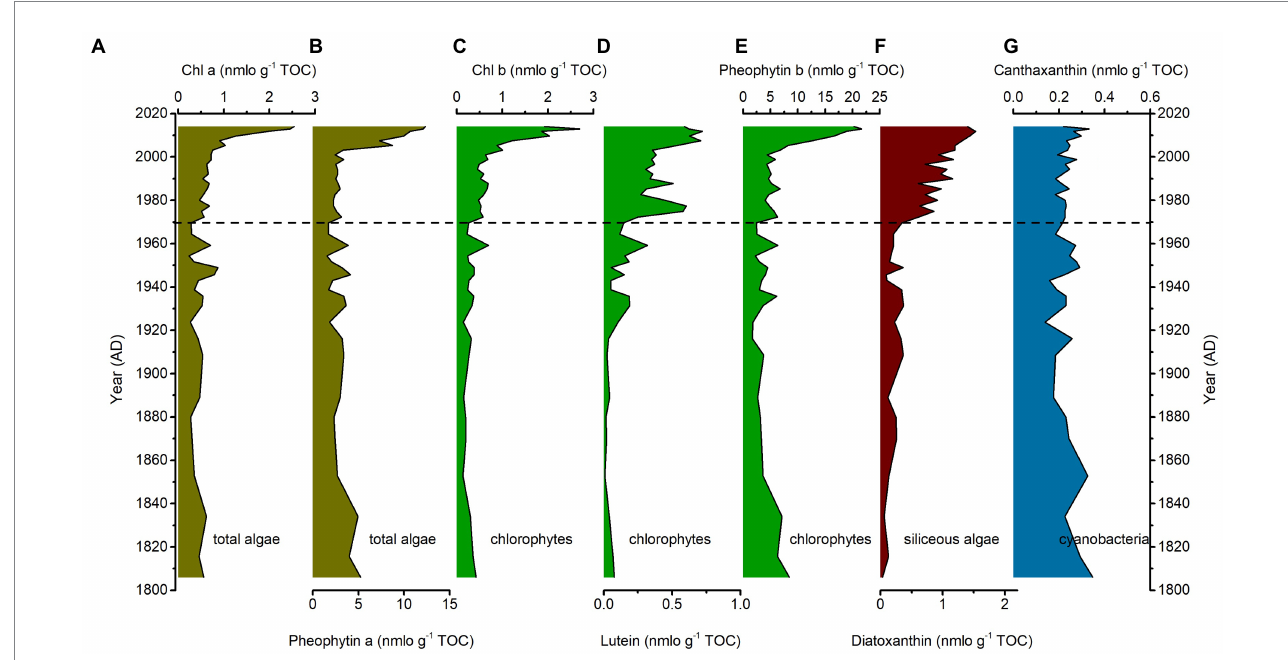
FIGURE 2 Sediment pigment. The concentration (nmol g − 1 TOC) of main pigment including (A) Chl α , (B) pheophytin α , (C) Chl b , (D) lutein, (E) pheophytin b, (F) diatoxanthin, and (G) canthaxanthin in the sediments at the CQ